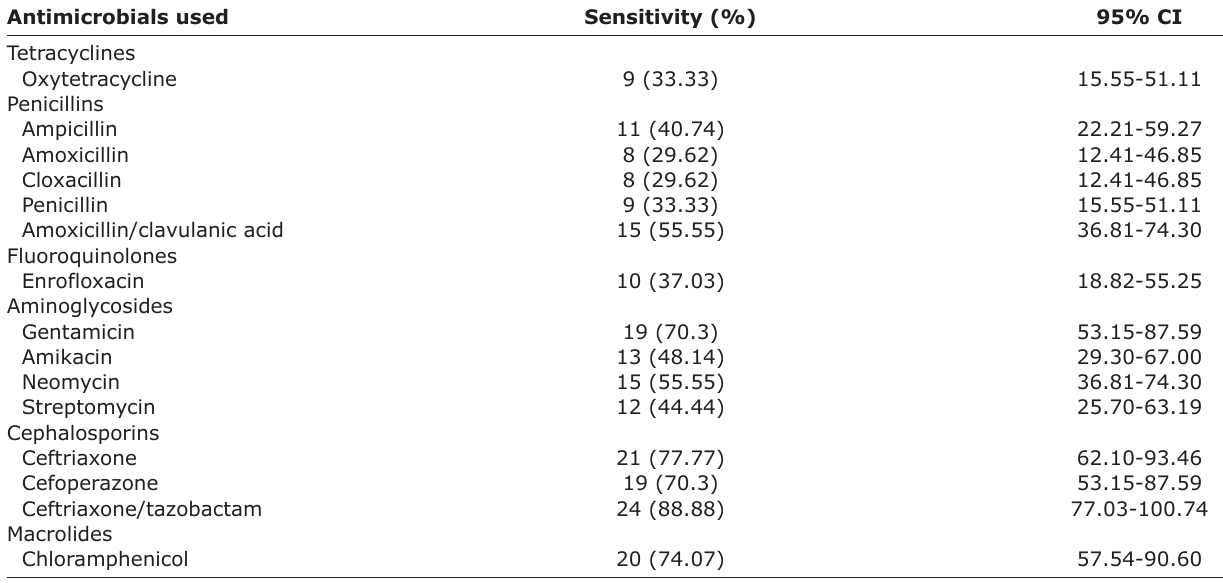
Table-2: Antimicrobial sensitivity pattern of different bacterial isolates from urine of dogs afflicted with UTI. Antimicrobials